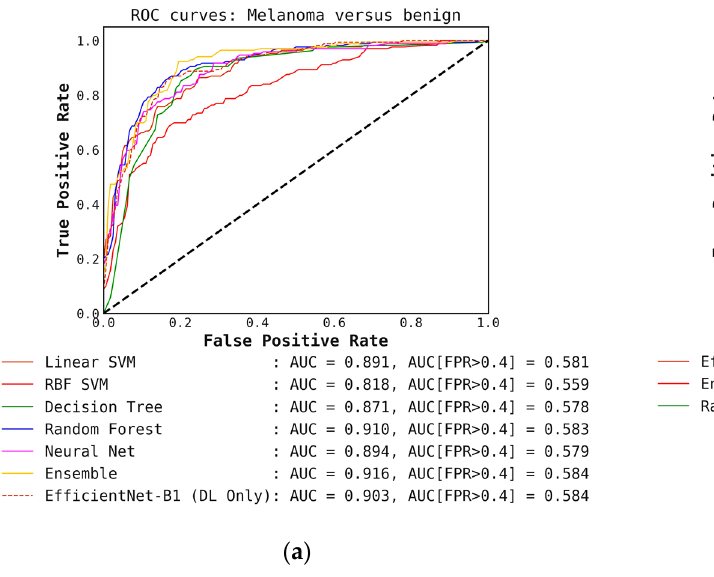
Figure A7. ( a ) ROC curves for conventional classifiers (level-1) used with the DL output probabilities from the EfficientNet-B1 (level-0) model and the hand-crafted features (cascade generalization); ( b ) Figure showing ROC curves only for the EfficientNet-B1 (level-0) model, the ensemble of con- ventional classifiers, and the best conventional level-1 classifier using the EfficientNet-B1 probability outputs. The AUC and the AUC for FPR higher than 0.4 are both presented for comparison. All values are rounded to three significant digits.